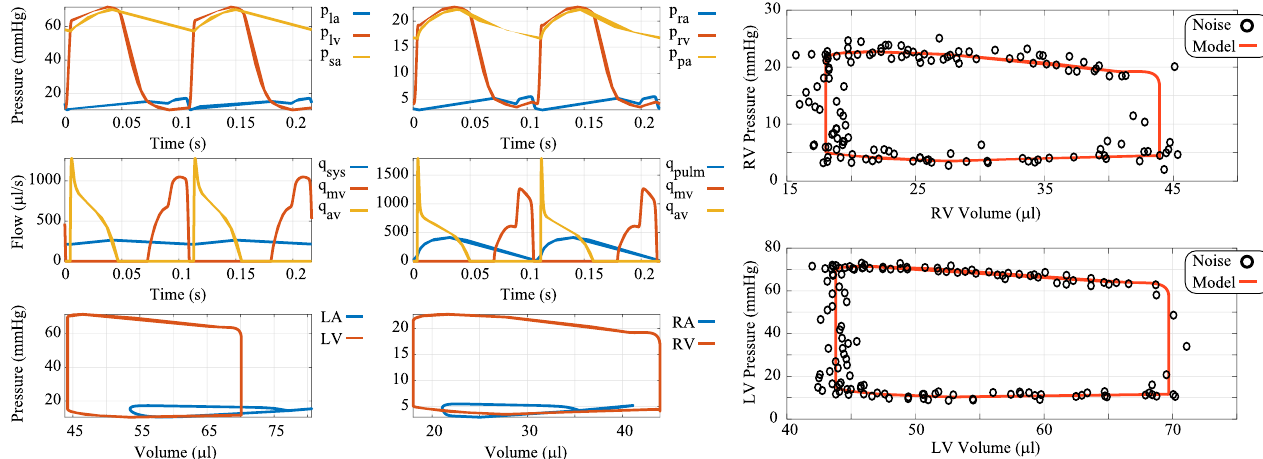
Fig 2. Nominal simulations and noise corrupted data. The nominal simulations are generated to match the data range reported by Philip et al. [23] in sham mice. Noise corrupted data is generated by adding additive, Gaussian errors with mean zero and a variance of 1.